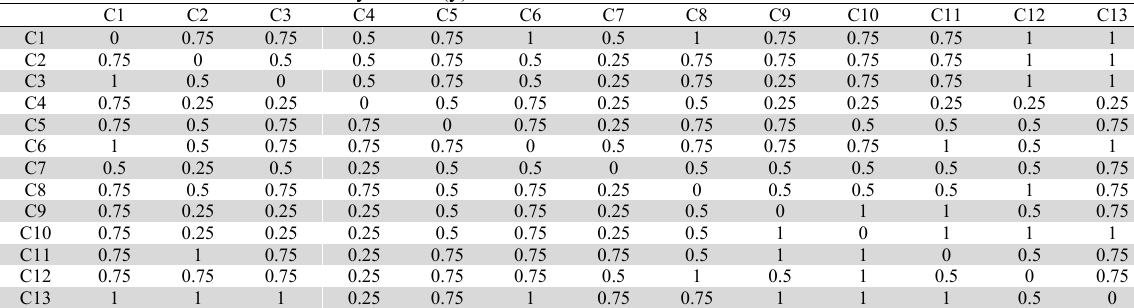
Normalized initial direct-relation fuzzy matrix (y)